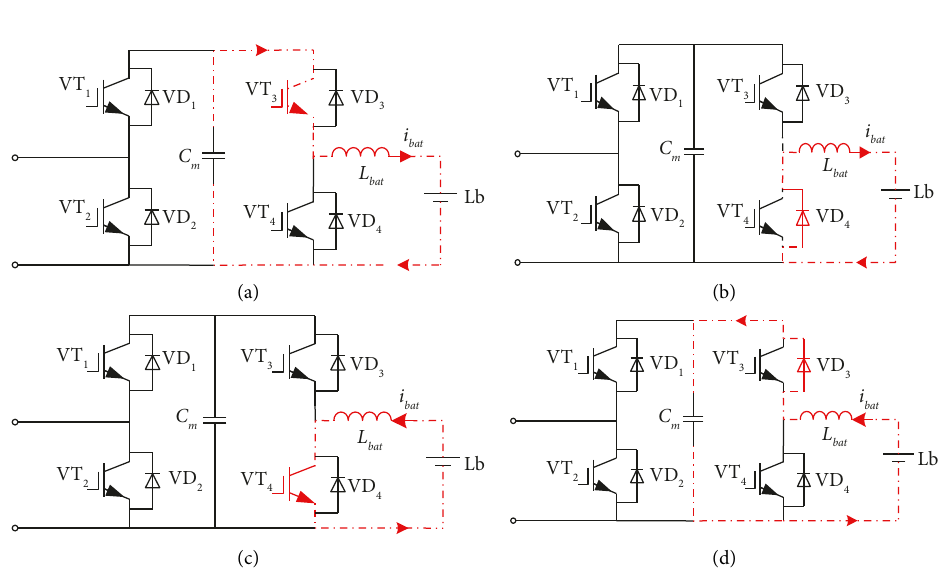
Figure 4: Energy interaction status of the lithium battery in the buck and boost working modes. (a) In the buck mode, with energy interaction. (b) In the buck mode, without energy interaction. (c) In the boost mode, without energy interaction. (d) In the boost mode, with energy